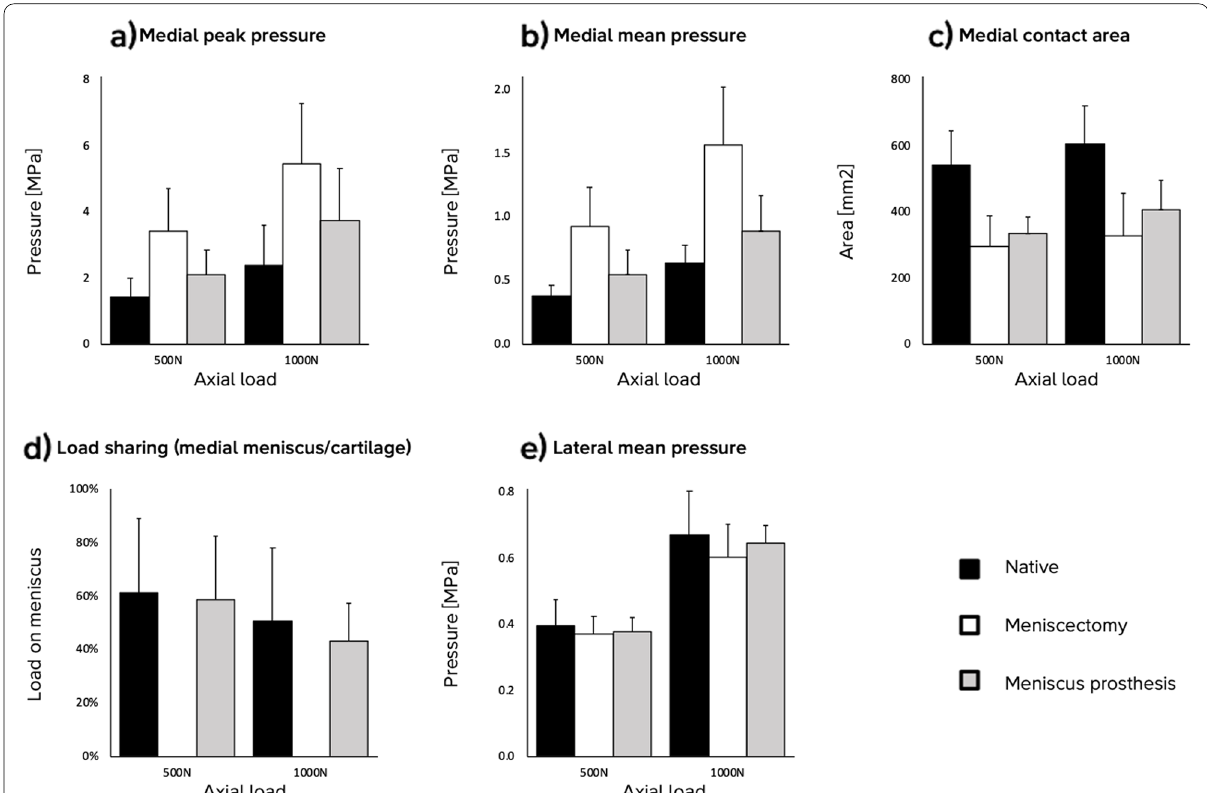
Fig. 10 Mean and standard deviation of the biomechanical outcome of the test in cadaveric knee joints, split into medial peak pressure, medial mean pressure, medial contact area, load sharing between the meniscus or prosthesis and the direct tibiofemoral contact, and lateral mean pressure